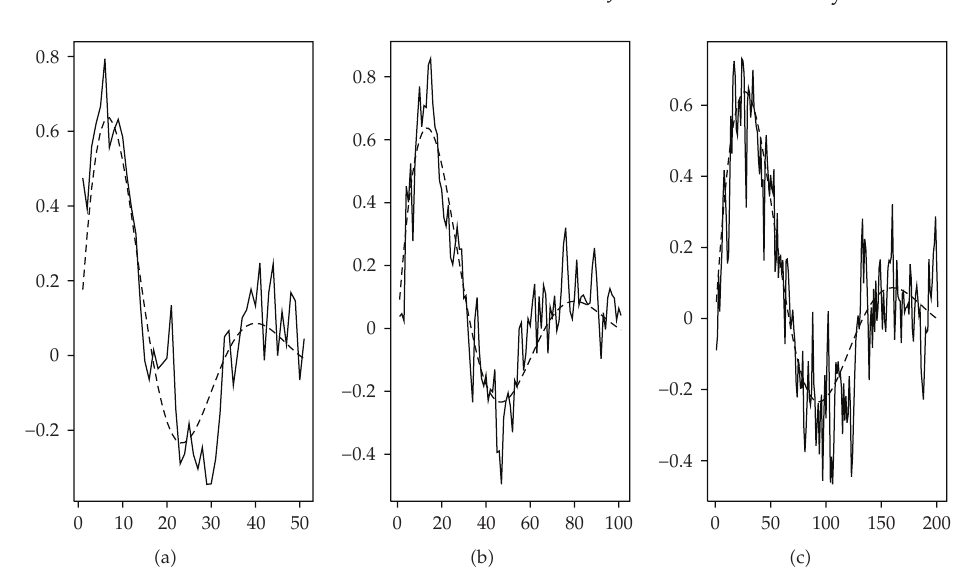
Figure 1: Simulation data with (cid:3) a (cid:6) n (cid:7) 50 and ρ (cid:7) 0 . 5, (cid:3) b (cid:6) n (cid:7) 100 and ρ (cid:7) 0 . 5, (cid:3) c (cid:6) n (cid:7) 200 and ρ (cid:7) 0 . 5. The dotted lines represent α (cid:3) t (cid:6) ; the solid lines α (cid:3) t (cid:6) (cid:8) ε (cid:3) t (cid:6)